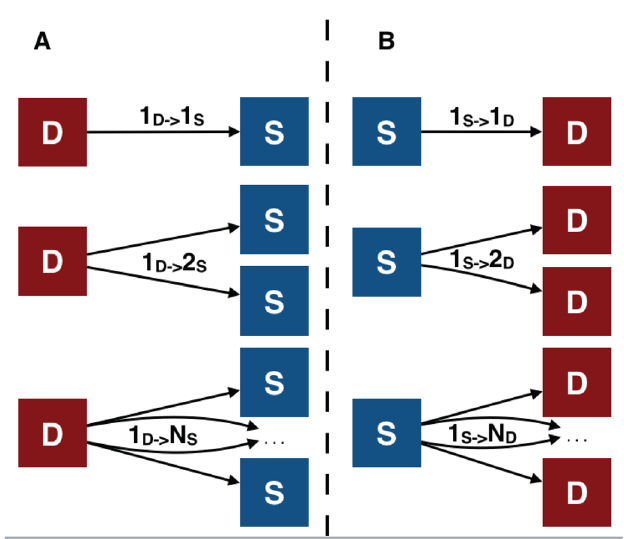
Figure 5. Summary of possible mismatches between DAB and SB clusters. Mismatches of SB and DAB derived clusters (marked by S and D respectively) can occur in two directions. Panel A : possible cases of mismatch when counting the number of SB clusters the sequences in a DAB cluster are assigned to. 1 d → 1 s denotes that all sequences from the D cluster are assigned to the same S cluster. 1 d → Ns denotes that sequences in a single D cluster are assigned to N distinct S clusters with N ≥ 1. Similarly, (panel B ) 1 s → Nd denotes that sequences in a single S cluster are assigned to N distinct D clusters with N ≥